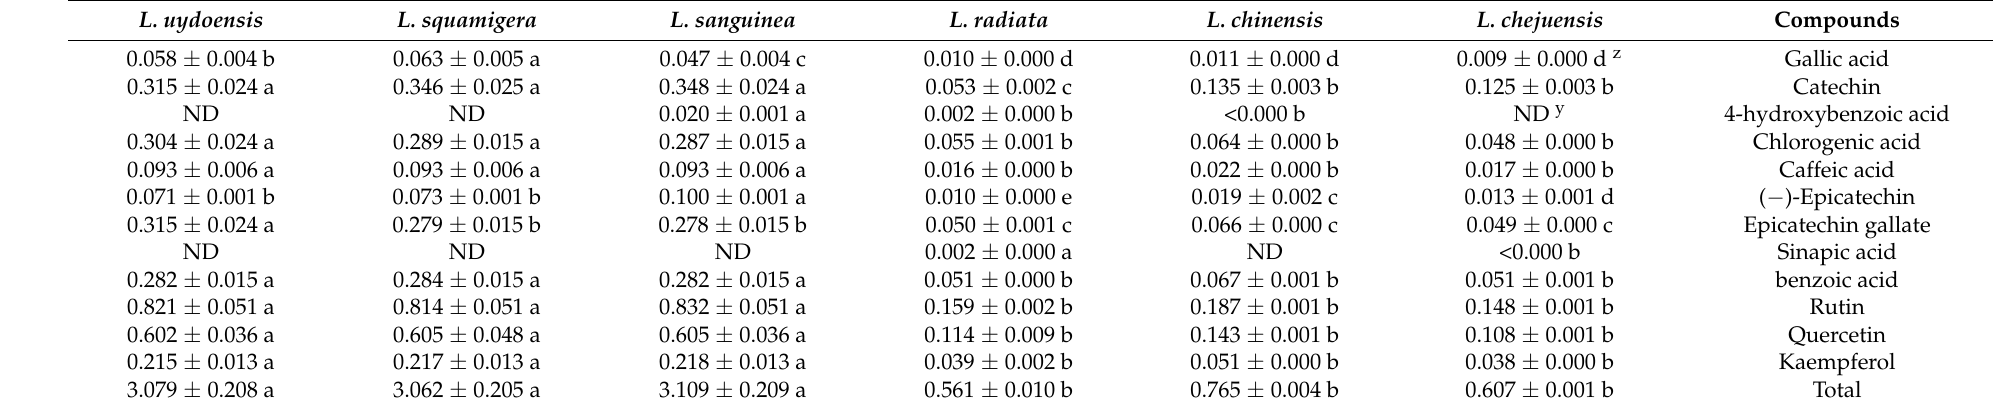
Table 1. Accumulation of phenylpropanoids in six Lycoris